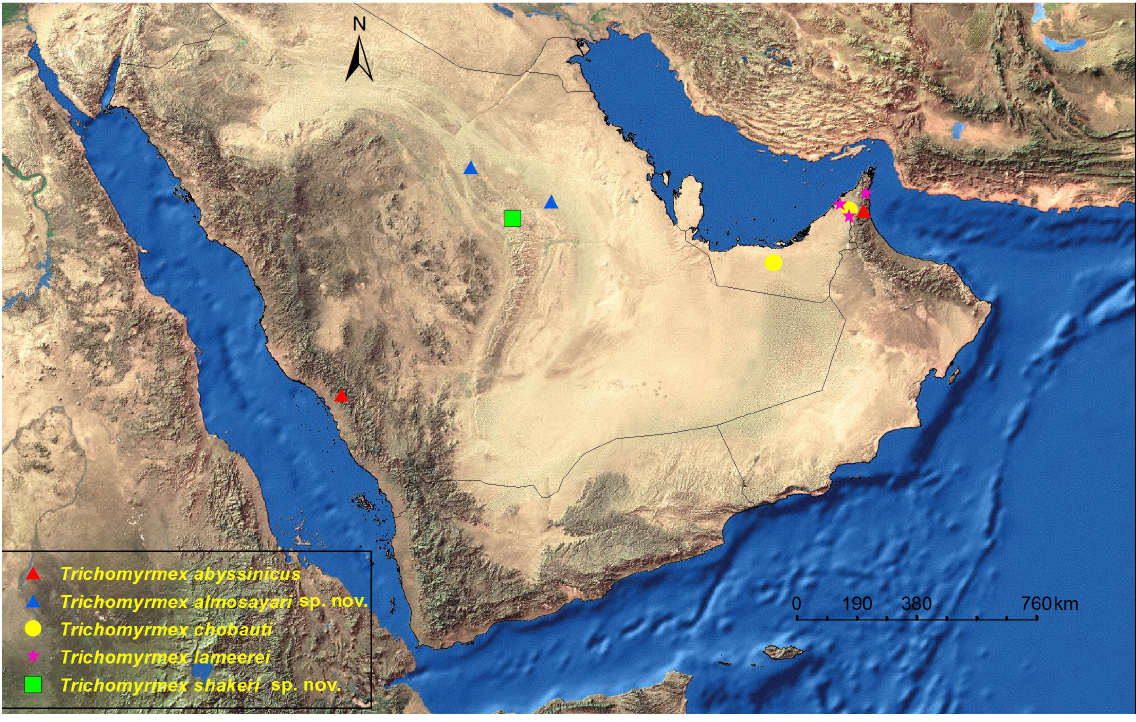
Fig. 14. Distribution map of Trichomyrmex abyssinicus (Forel, 1894a), T. almosayari sp. nov., T. chobauti (Emery, 1897), T. lameerei (Forel, 1902) and T. shakeri sp. nov.